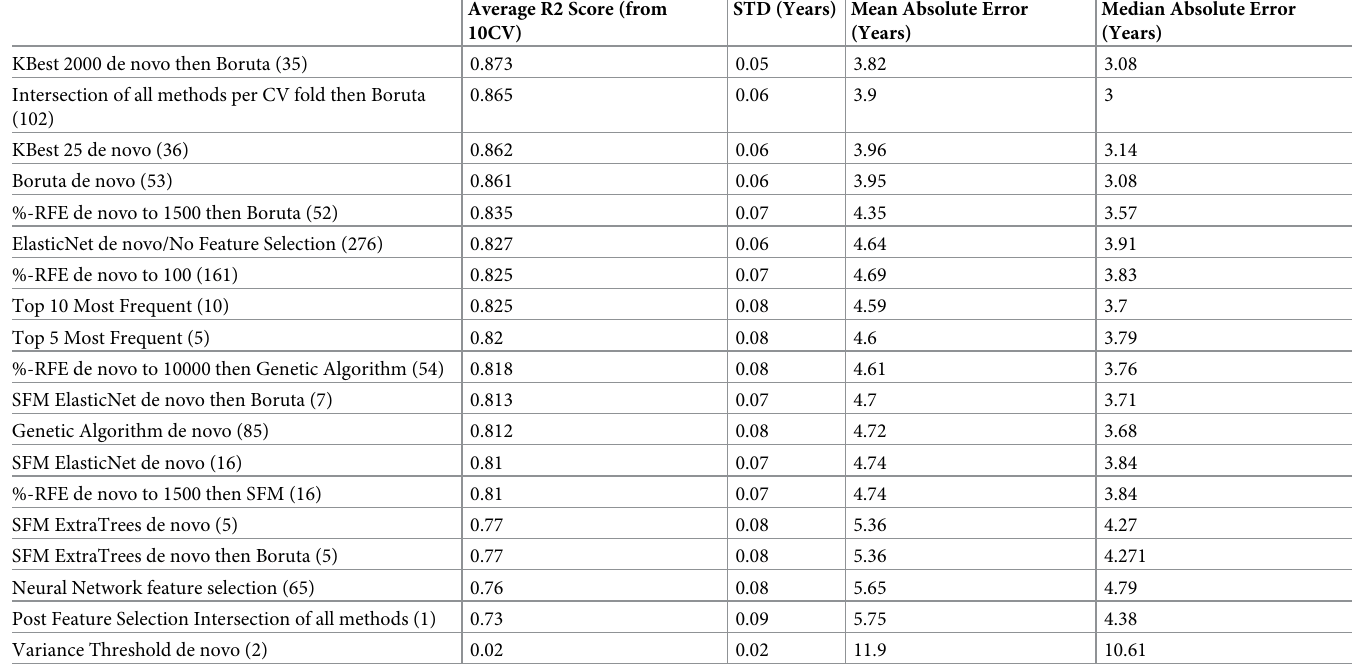
Table 1. Feature selection methodology (in descending order of correlation scores). Number of features selected by each method parenthesized in the first column. Average R2 Score (from 10CV)